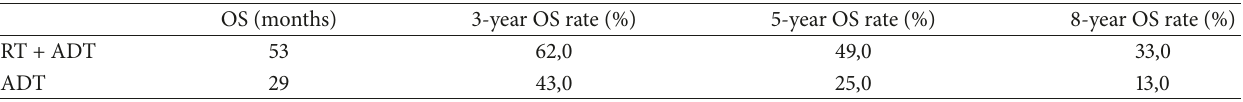
Table 10: Overall survival and surgery-free survival rate by therapeutic modality, adapted from Heidenreich et al. [18]. Therapeutic modality OS rate (%) CSS rate (%) Surgery-free survival rate RP 91,3 95,6 100,0 NLT 78,9 84,2 71,1 OS: overall survival; CSS: cancer-specific survival; RP: radical prostatectomy; NLT: no local treatment.